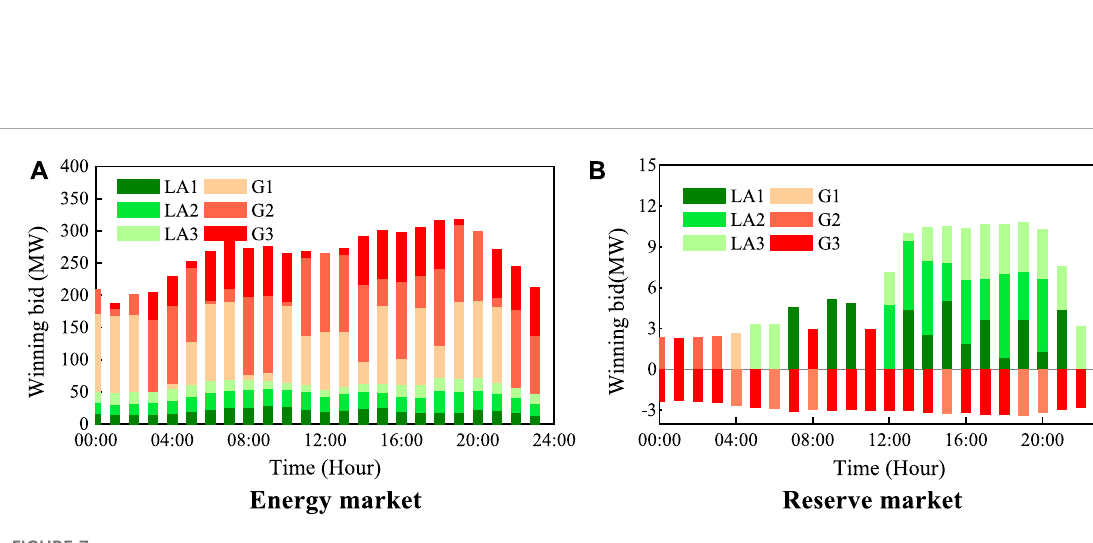
FIGURE 7 The market-clearing results for the day-ahead energy market. (A) Energy market and (B) reserve market.